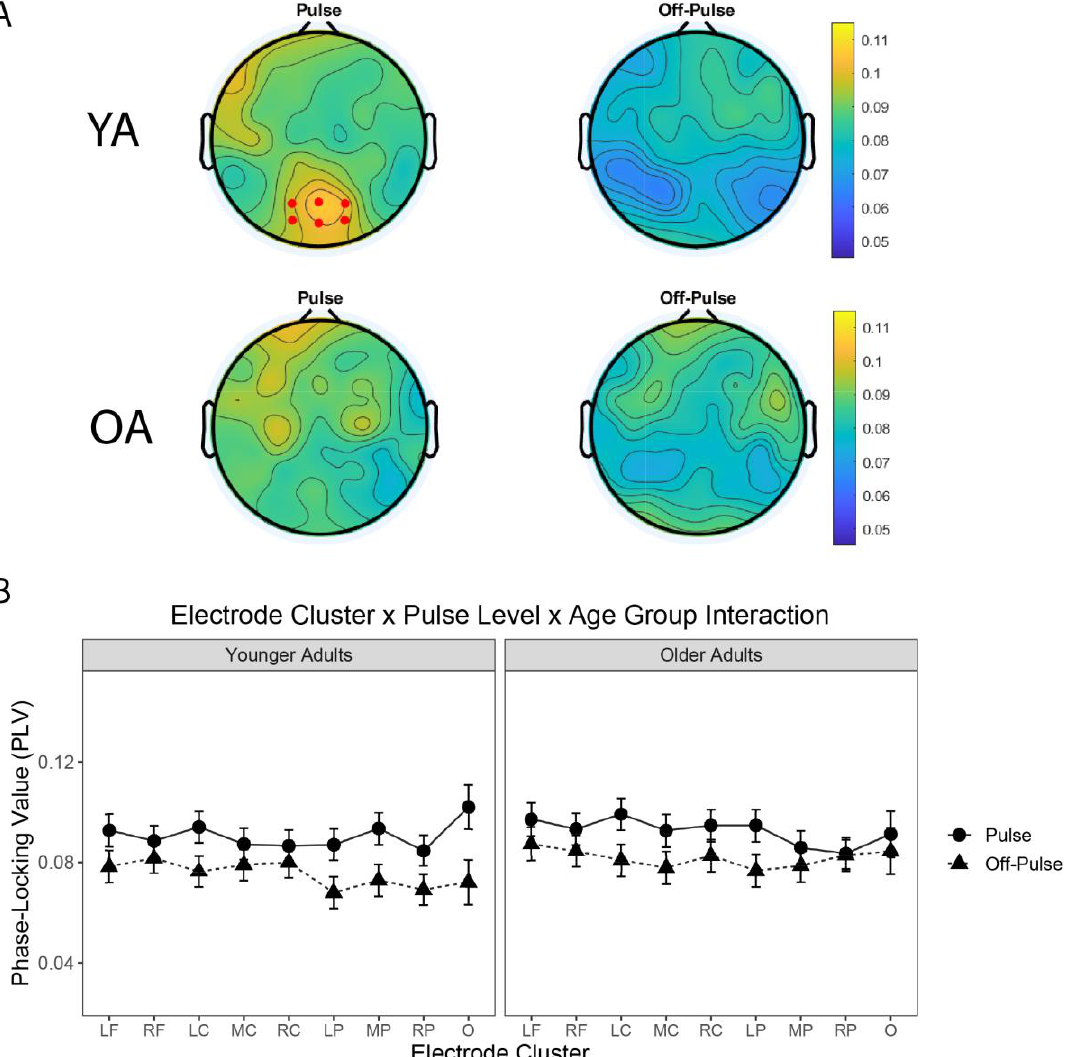
Figure 4. Neural entrainment interacts with electrode cluster and age group. ( A ) Topographies of the phase-locking values (PLVs) for the pulse and off-pulse levels. Younger adults (top row) exhibited higher PLVs at the pulse level in a cluster of parietal–occipital electrodes (e.g., electrode cluster O, red dots denote which channels constitute that cluster). Older adults (bottom row) exhibited a more uniform topography of PLVs at the pulse level. ( B ) Mean PLVs representing a three-way interaction between rhythm level (pulse, off-pulse), electrode cluster (nine clusters), and age group (younger adults, older adults). Error bars are standard error of the mean